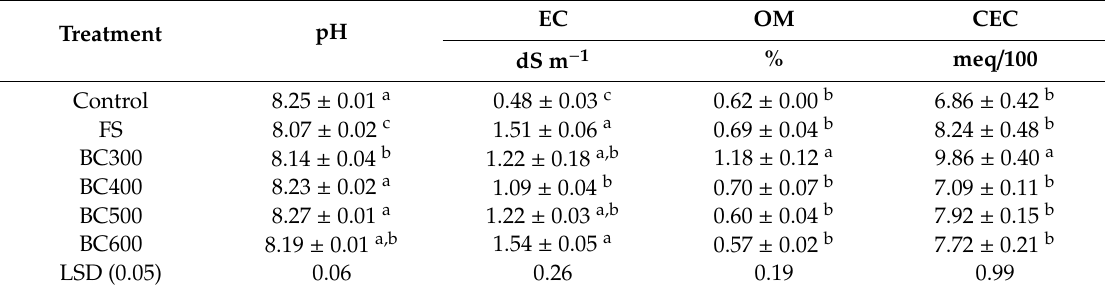
Table 2. E ff ects of experimental treatments on the selected soil chemical